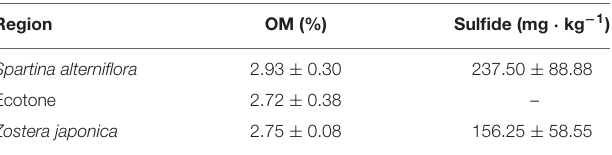
FIGURE 4 | Total shoot density of Spartina alterniflora and Zostera japonica at the 11 sampling points in April (A) , July (B) , and October (C) 2019. All S. alterniflora shoots collected at sampling points 9 and 10 in July 2019 were grown from dormant seeds that germinated in May 2019. Values are mean ±